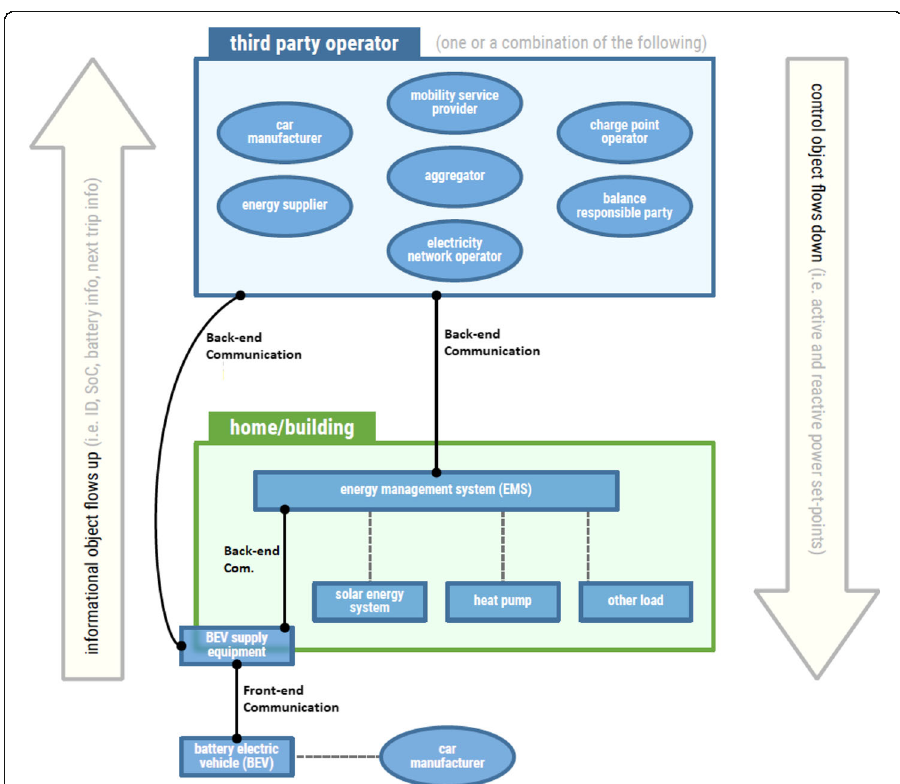
Fig. 2 Various EV ecosystem entities connected by communication protocols. Information and control objects must flow through entities to ensure proper grid integration. A direct communication link between a third party operator and charge points (referred here as BEV supply equipment) is specifically applicable for public charging infrastructure such as residential on-street chargers. For private charging infrastructure, we argue that communication to the charger would go through an EMS to optimise multiple resources co-located with BEVs (i.e. heat pumps, solar energy systems) at home or a workplace